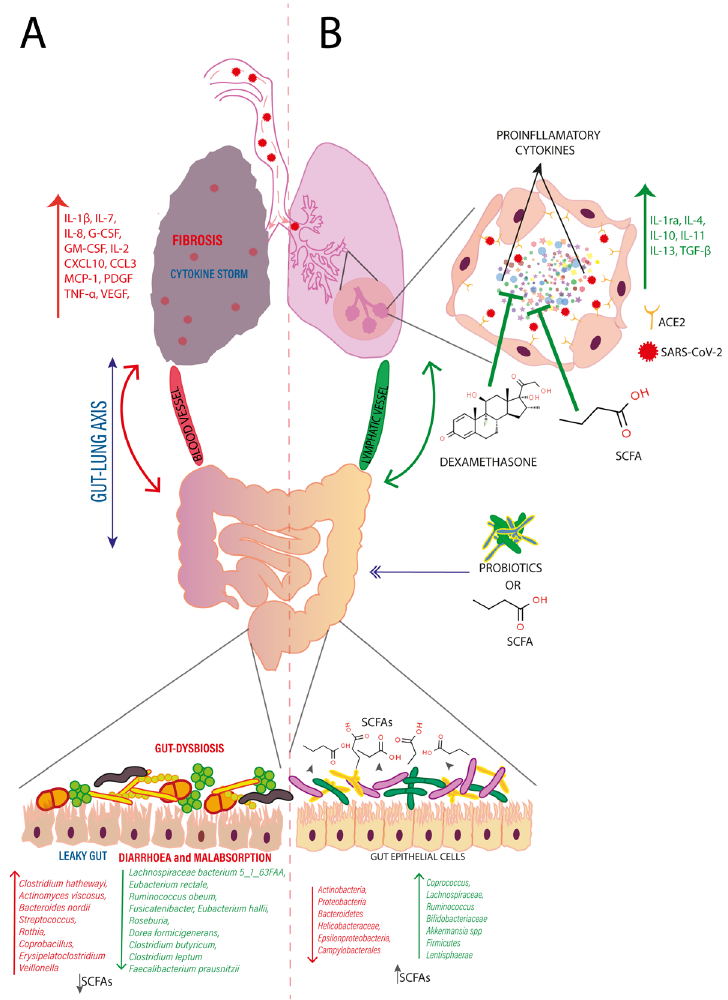
Figure 2. A. SARS-CoV-2 transmitted through aerosols reach the lungs via respiratory tract and enters the host cell by binding to its receptor, ACE2 present on the surface of pneumocytes. Followed by endosome mediated internalization, SARS-CoV-2 causes cell injury and subsequent hyperinflammation and cytokine storm, resulting in fibrosis of lungs. These cytokines reach the gut via blood and lymphatic vessels that instigates local inflammation in gut, ushering to leaky gut and gut dysbiosis, resulting in diarrhoea and malabsorption together with reduced production of short chain fatty acids. B . Dexamethasone a synthetic broad-spectrum immunosuppressant can inhibit cytokine storm associated with CoVID-19. As an alternative, oral administration of probiotics or gut microbiome metabolite, SCFAs may ameliorate gut inflammation, restore gut integrity, and gut microbiome. This enhances the production of endogenous SCFAs and reaches the lungs via blood and lymphatic vessels, and may inhibit hyperinflammation and cytokine storm along with induction of anti-inflammatory cytokines production which recovers the lung from injury and the acute respiratory distresses associated with